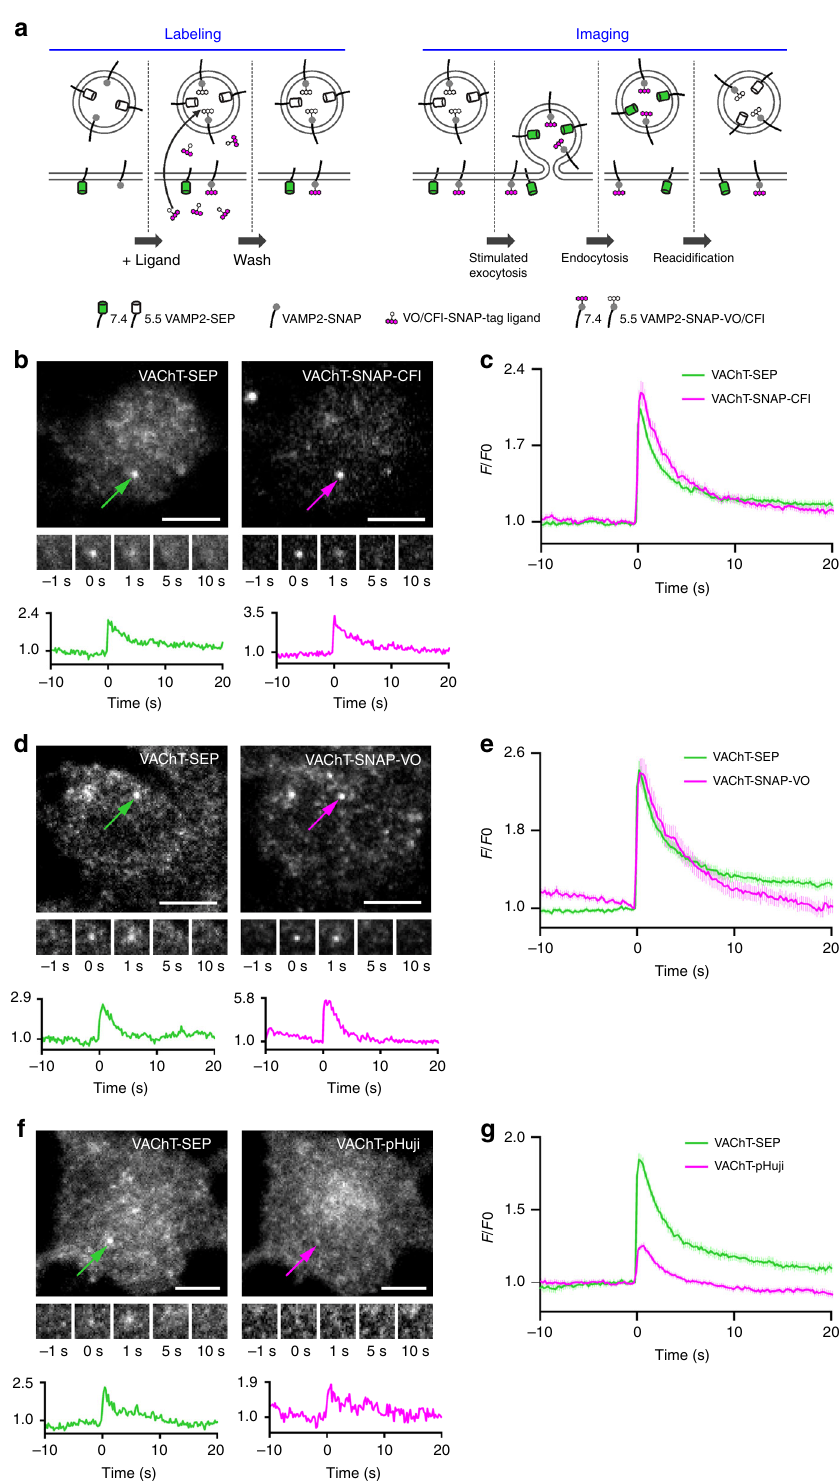
Fig. 2 Detection of single exocytosis events in PC12 cells. a Experimental scheme: prior to imaging, cell-permeable VO/CFl-SNAP-tag ligand is incubated with transfected neuronal cultures to speci fi cally label VAMP2-SNAP. Both VAMP2-SEP and VAMP2-SNAP-VO/CFl are quenched at acidic pH and exhibit maximal fl uorescence at the surface. b , d , f TIRF microscopic images of PC12 cells expressing VAChT-SEP (left) and VAChT-red shifted indicator (right) undergoing fusion. Images of whole cell with a fusion event indicated with arrow (top); time-lapse of the marked exocytic event (middle, 3.5 × 3.5 µ m); normalized intensity traces for the marked event in the green and red channels (bottom); scale bars: 5 μ m. b VAChT-SNAP-CFl. d VAChT-SNAP-VO. f VAChT-pHuji. c , e , g Plots of normalized fl uorescence vs. time averaged across single-vesicle fusion events for vesicles labeled with VAChT-SEP (green) or VAChT-red-shifted indicator (magenta); error bars show ± s.e.m. c VAChT-SNAP-CFl, n = 113 events from 5 cells. e VAChT-SNAP-VO, n = 116 events from 10 cells. g VAChT-pHuji, n = 126 events from 3